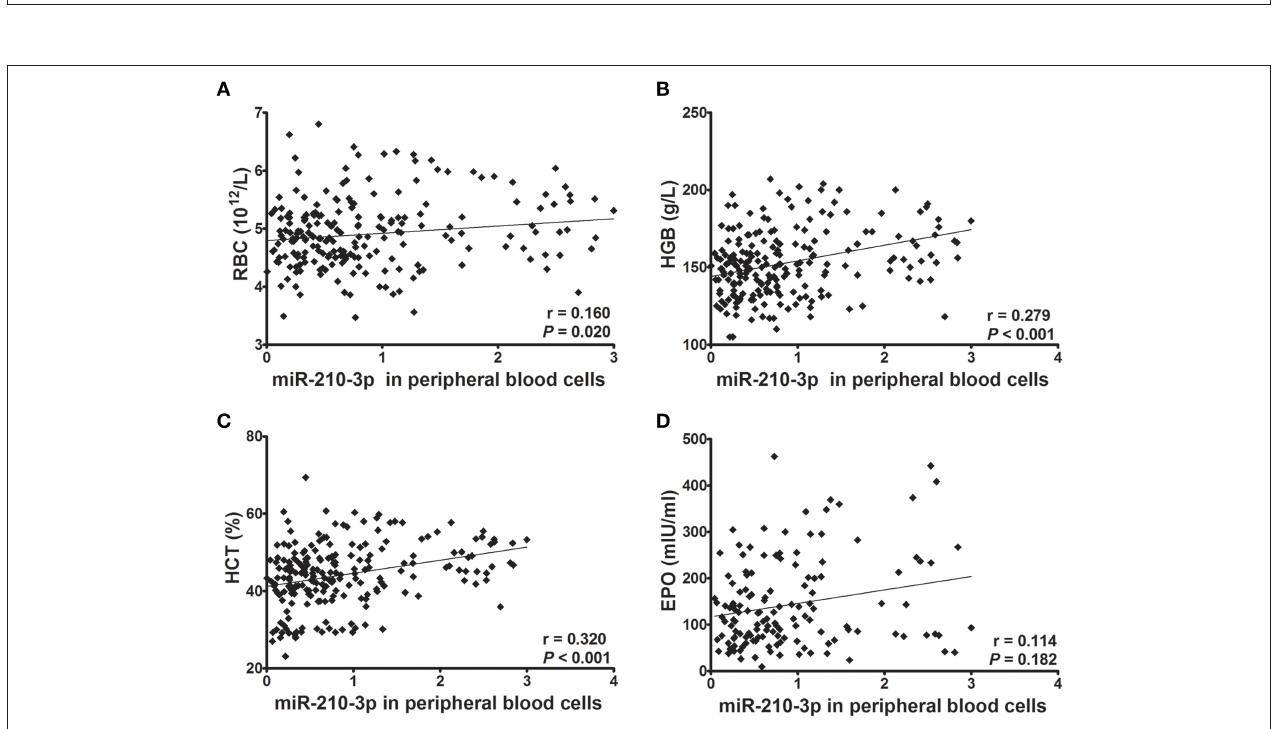
FIGURE 3 | The correlations of miR-210-3p expression levels in peripheral blood cells with hematological indices and plasma EPO concentrations ( n = 212 ). (A–D) Correlations of miR-210-3p expression levels in blood cells with red blood cell count (RBC) and with hemoglobin (HGB), hematocrit (HCT), and plasma erythropoietin (EPO) values, calculated by Spearman’s rank correlation analysis.